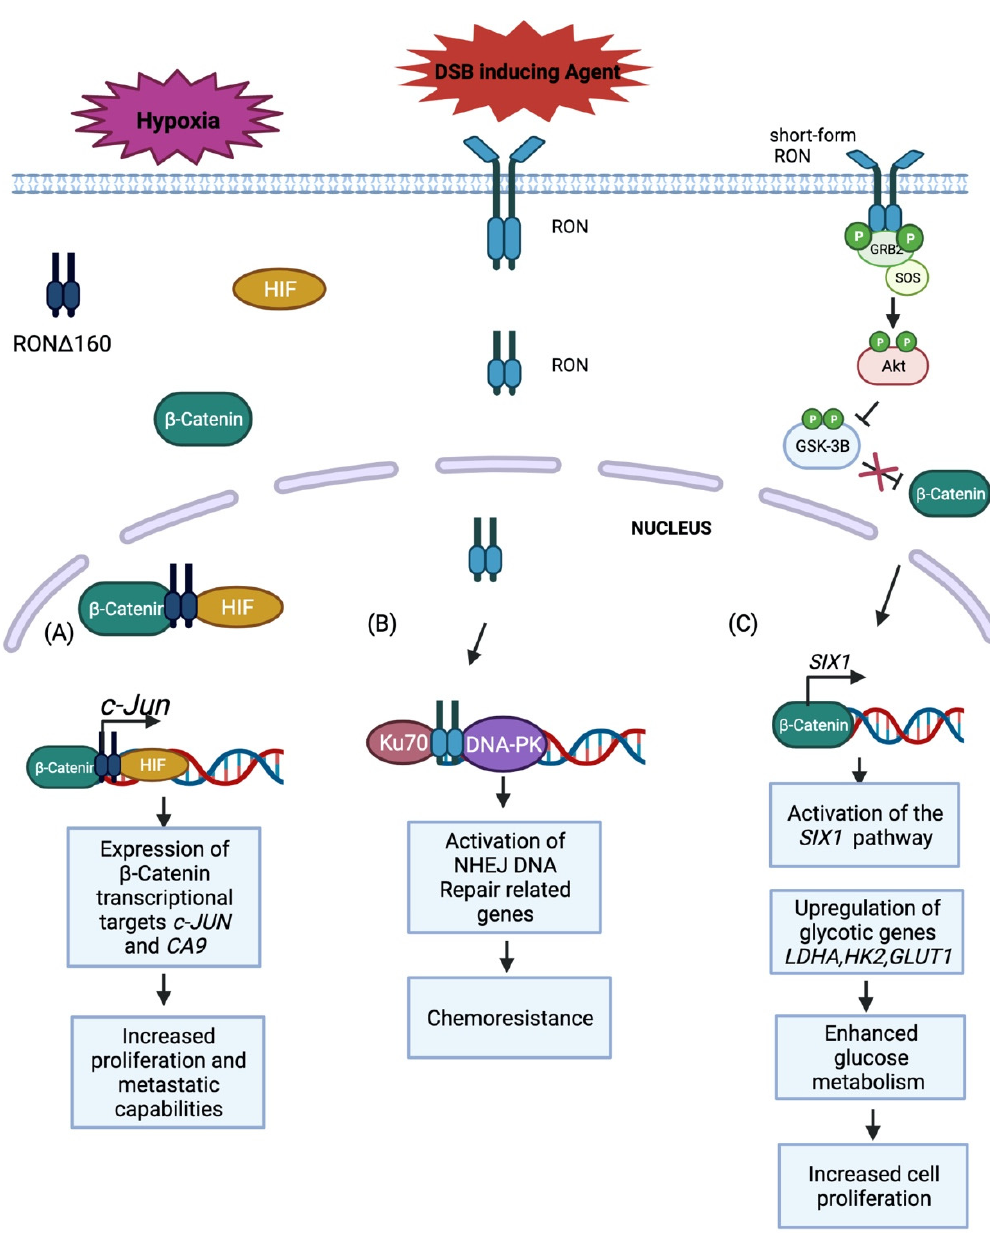
Figure 2. Model demonstrating the role of RON as a transcription factor that promotes cell survival during cellular stress. ( A ) Under hypoxic conditions, a RON splicing variant, RONd160, binds to hypoxia induced factor (HIF) and b-catenin to form a complex that translocates to the nucleus and drives the expression of b-catenin target genes like c-jun and ca-9. The upregulation of these genes leads to increased cell proliferation and metastatic capabilities that drives tumorigenesis. ( B ) In response to treatment with chemotherapeutic agents, RON translocates to the nucleus and binds with Ku70 and DNA-PK to form a complex that drives the expression of genes related to Non-homologous endjoining (NHEJ) pathways. This form of dna repair prevents apoptotic events that would normally be activated due to DSB in DNA, making these cells resistant to chemotherapy. ( C ) A constitutively active form of RON (sf-RON) activates the AKT pathway through phosphorylation. AKT then phosphorylates GSK-3B to inhibit its function. Inactive GSK-3B cannot inhibit B-catenin which is free to enter the nucleus and activate the S1X1 pathway which the drives the expression of glycotic genes. Upregulation of these genes enhances glucose metabolism which increases cell proliferation that is necessary for tumorigenesis.